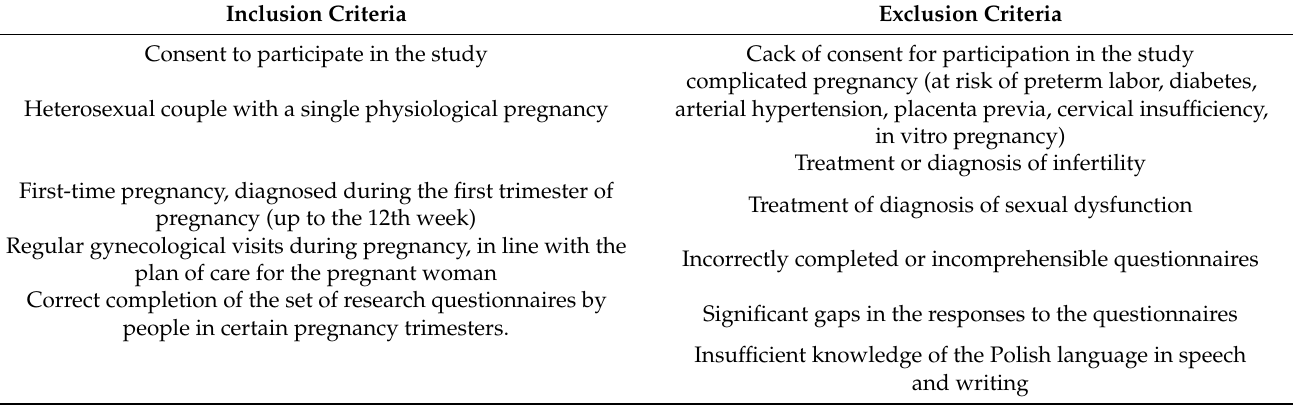
Table 1. Inclusion and exclusion criteria from this